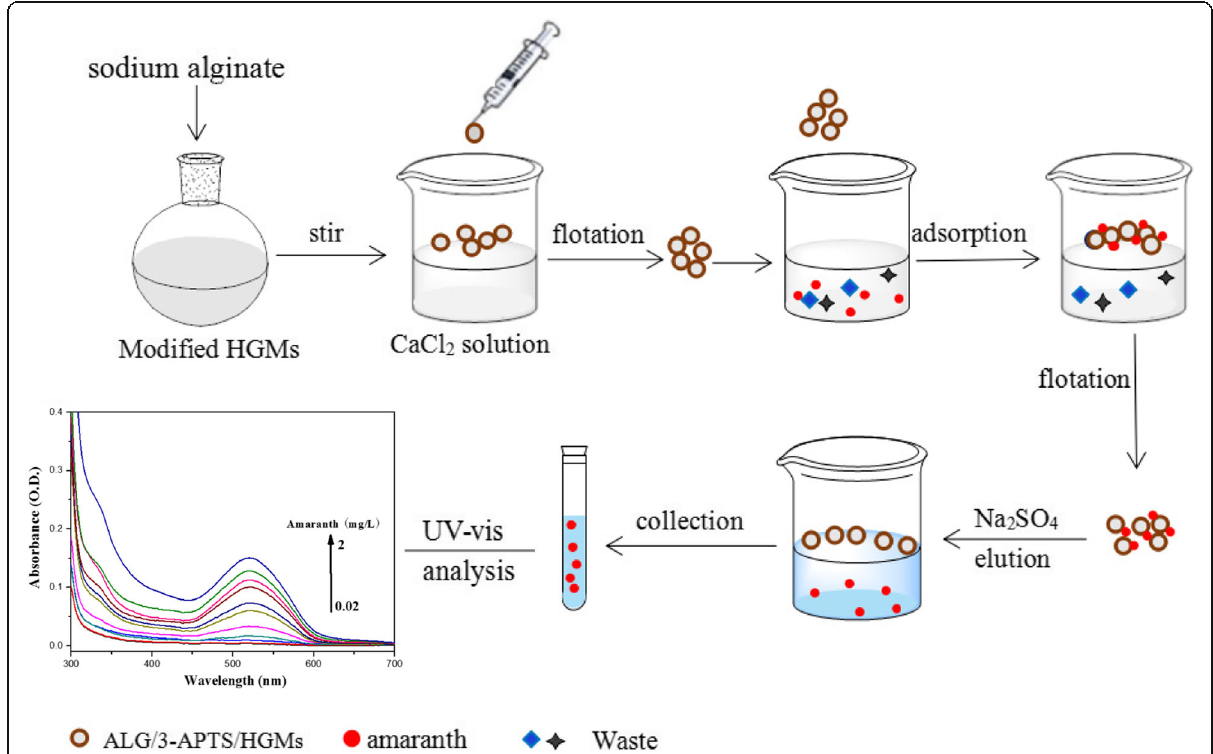
Fig. 1 Schematic illustration of ALG/3-APTS/HGMs preparation and amaranth